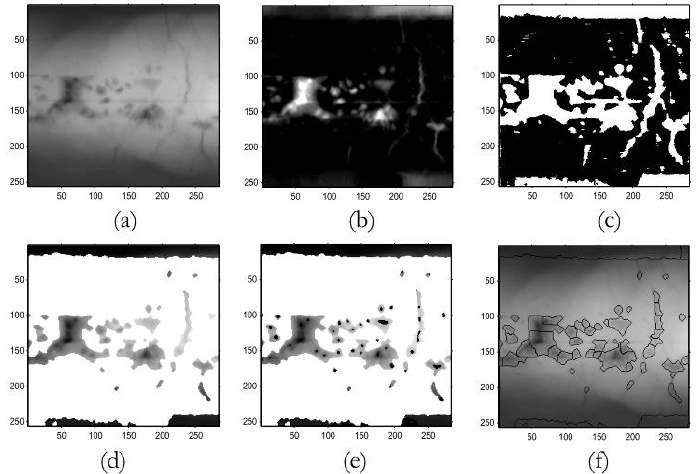
Figure 3. Summary of the proposed segmentation process: ( a ) image-altering the application of the median filter. ( b ) Application of the Bottom-Hat filter. ( c ) Application of binary thresholding. ( d ) Application sectioning process. ( e ) Modification of minima. ( f ) Application of the Watershed transformation